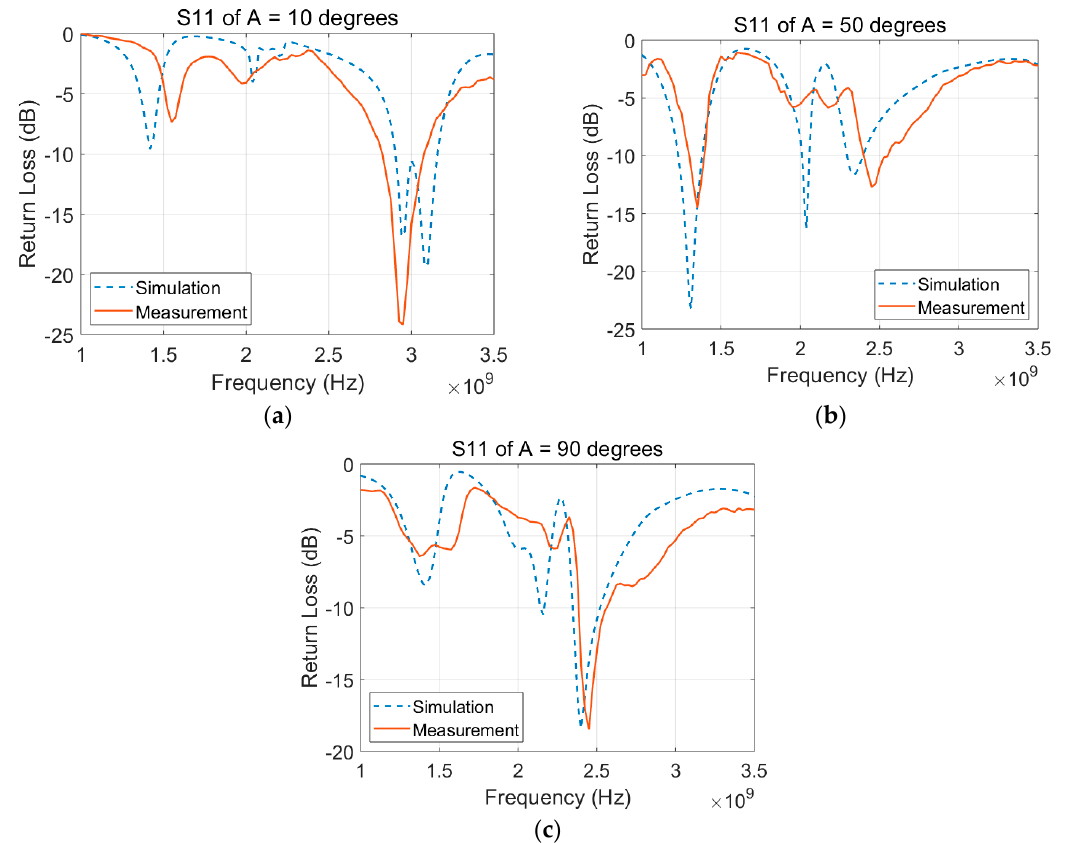
Figure 5. Reflection Coefficients of Simulation and Measurement. ( a ) A = 10°, ( b ) A = 50°, ( c ) A = 90°.